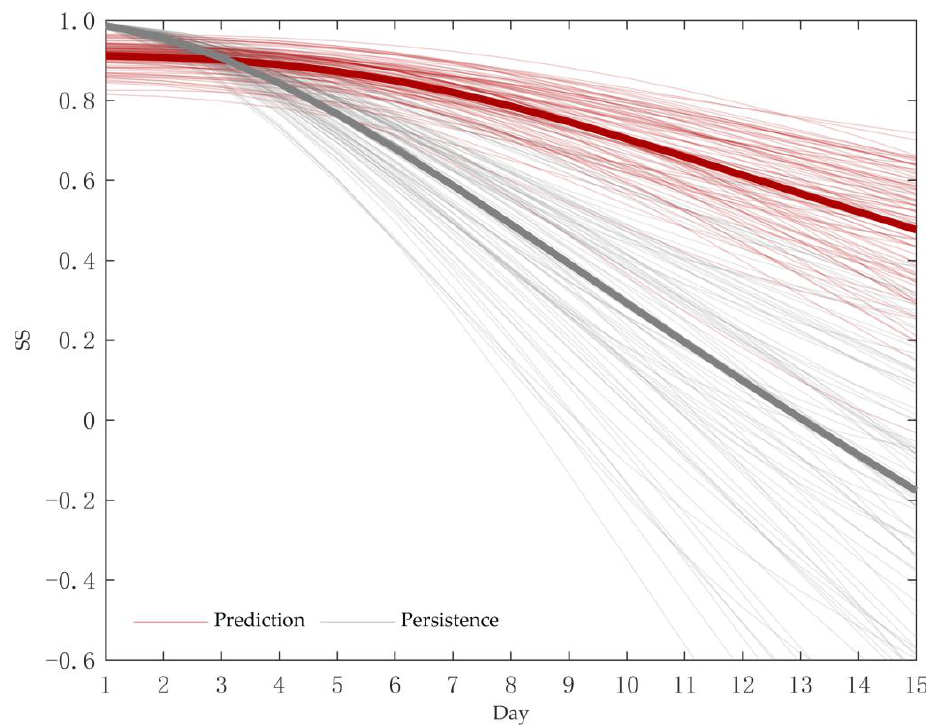
Figure 10. Averaged skill score of SLA for prediction (red) and persistence (gray) from 18 April 2014 to 31 December 2017. The thin line is the 15-day average, and the thick line is the three-year average.